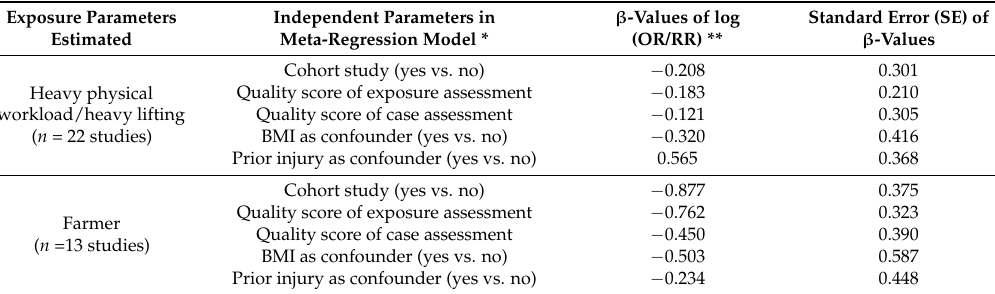
Table 7. Results of meta-regressions of all published